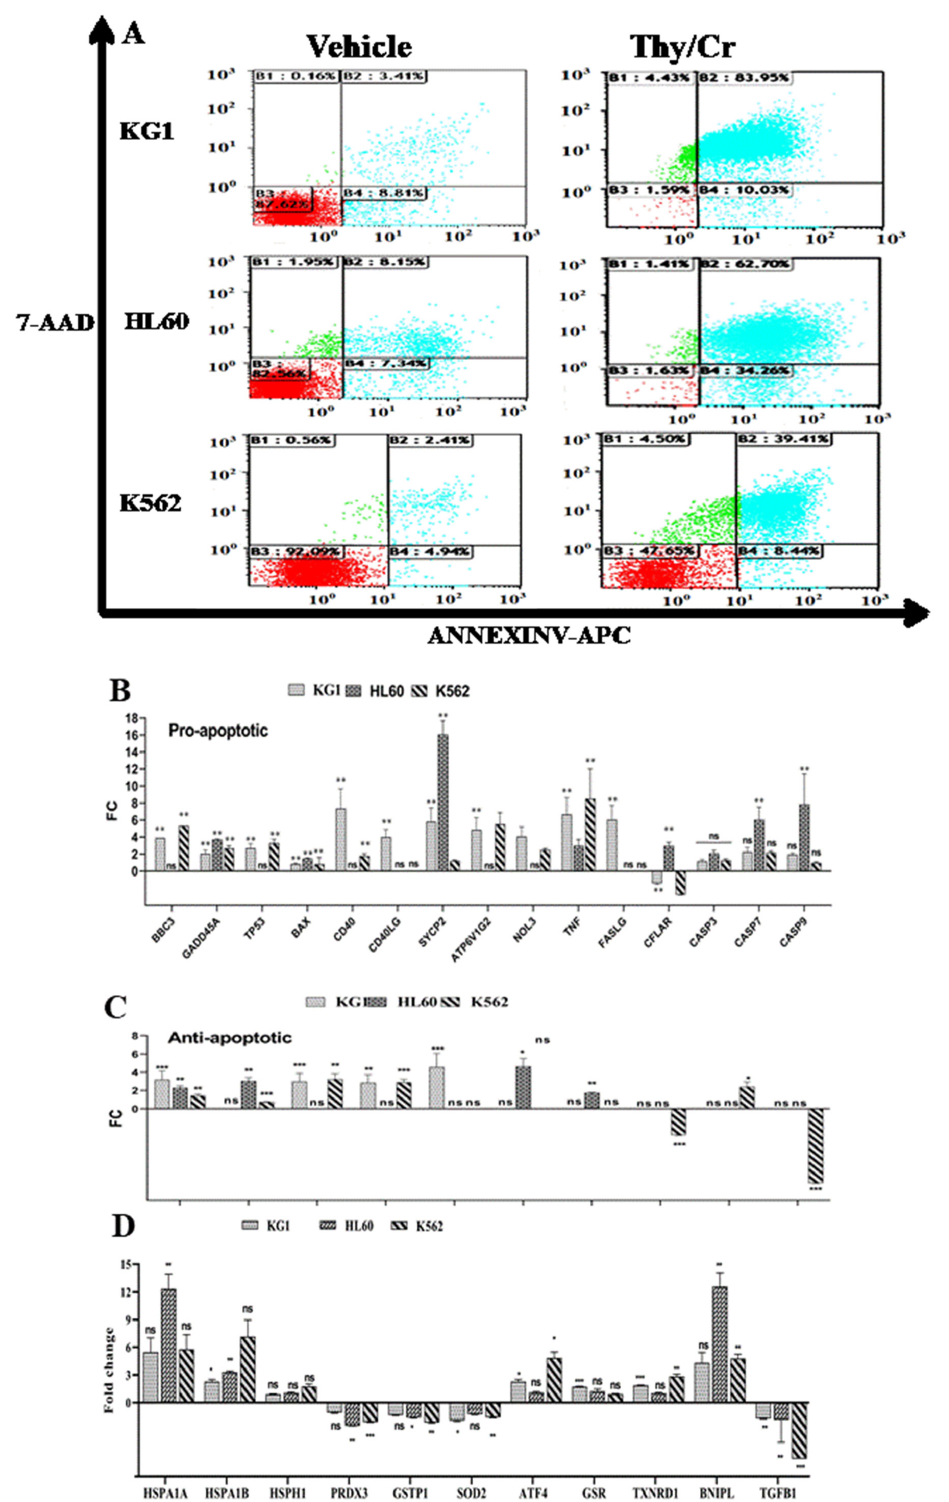
Figure 7. ( A – D ) Effect of carvacrol and thymol combination in cell death induction through apoptotic and cell stress pathways. ( A ). Flow cytometric analysis of cell death with Annexin V-APC/7-AAD double staining after 48 h treatment of KG1, HL60, and K562 cell lines with Thy 50 µ M/Cr 300 µ M combination. Data were analyzed by Kaluza software 2.1. ( B ) and ( C ). Relative expression of genes related to apoptotic cell death. ( D ) Relative expression of genes related to cell and oxidative stress pathway. Data represent the mean ± SEM of three independent experiments relative to vehicle. The levels of statistical significance as done by Anova test were set at p < 0.05 (*), p < 0.01 (**) and p < 0.001 (***). ns: no